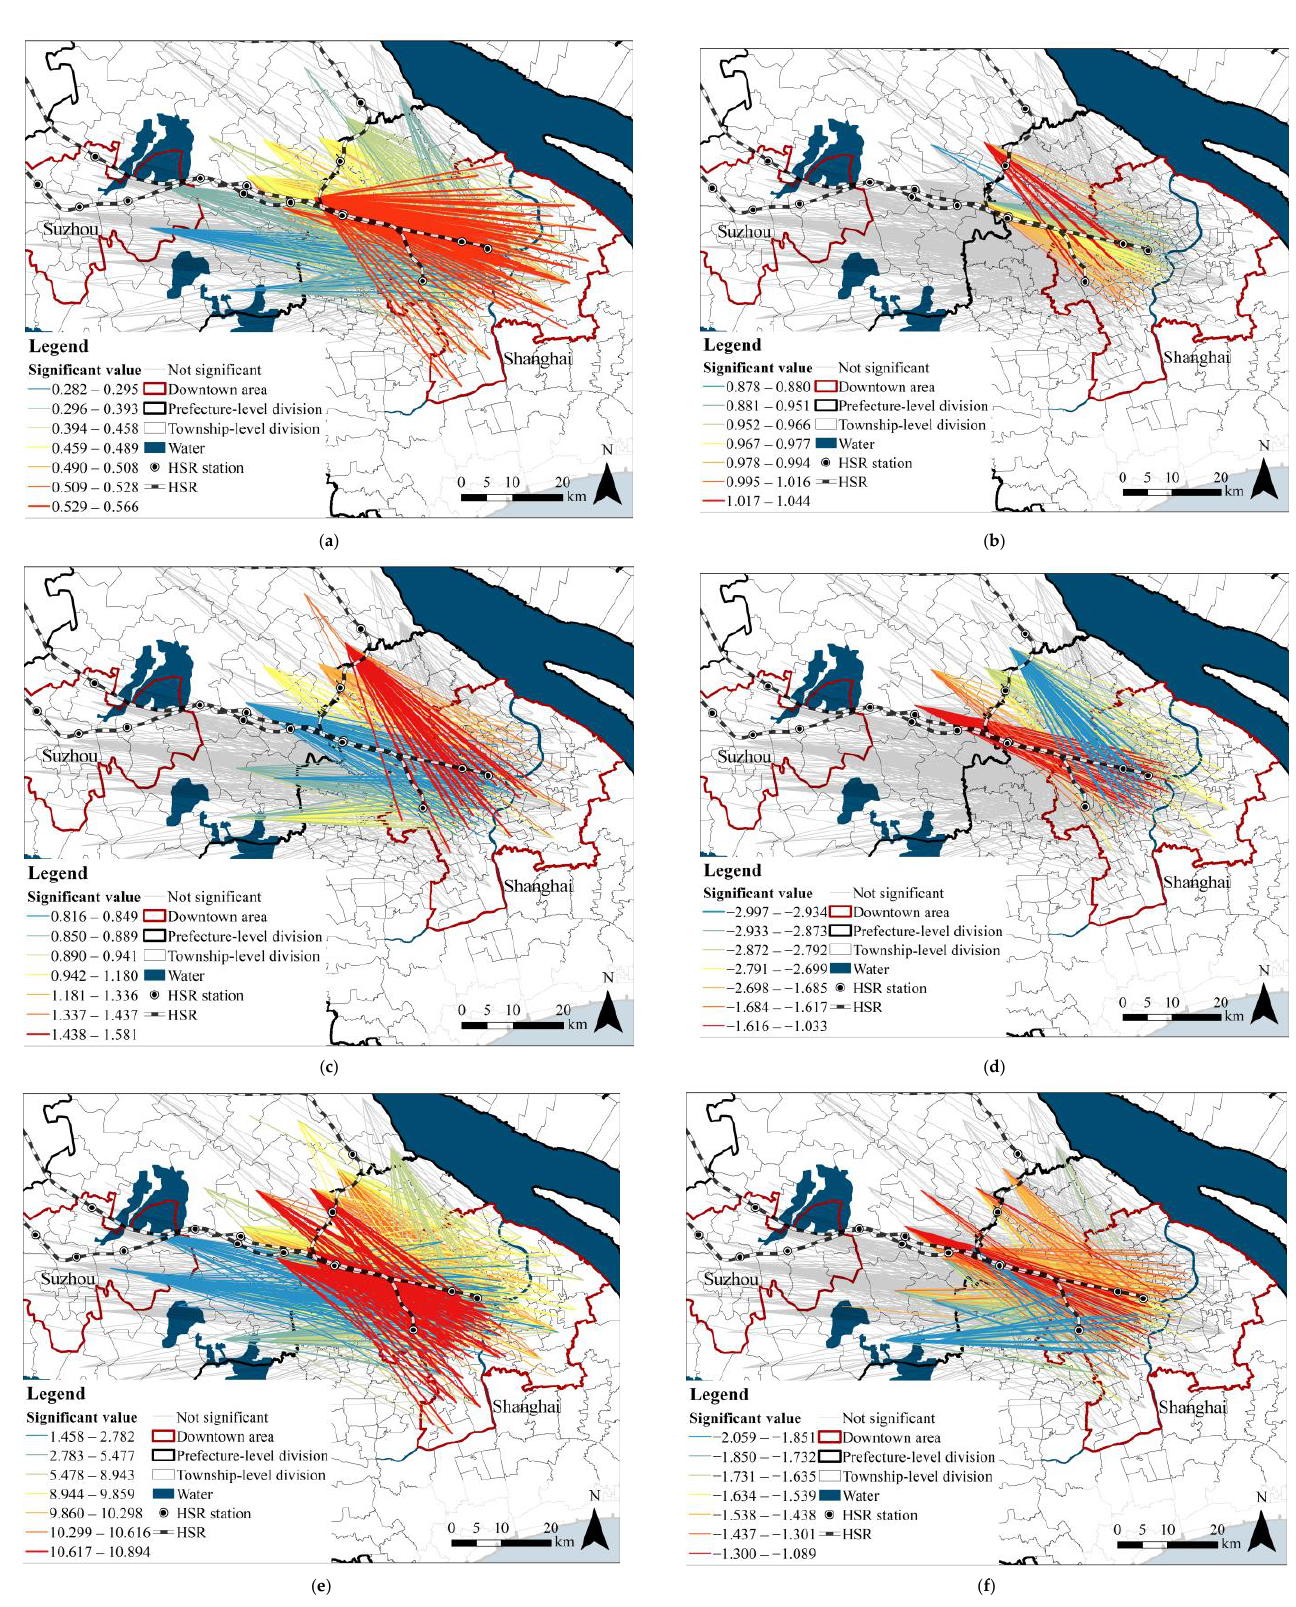
Figure 5. Spatial variation in coefficient estimates. ( a ) Scale of producer services in workplace; ( b ) Scale of non-producer services in residence; ( c ) Housing supply in residence; ( d ) Housing price in residence; ( e ) Year of construction in residence; ( f ) Commuting time.